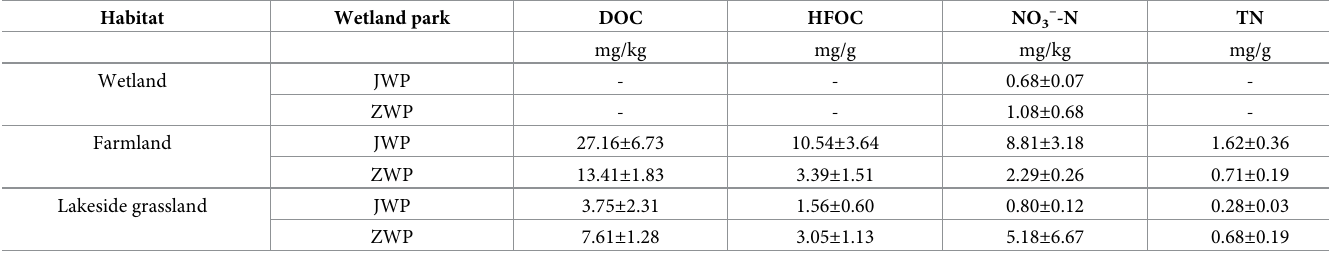
Values are expressed as mean ± standard deviations. JWP is Shili Lake Ecological Wetland Park. ZWP is Shandong Zoucheng Taiping National Wetland Park. DOC: dissolved organic carbon; HFOC: heavy fraction organic carbon; NO 3– -N: nitrate nitrogen; TN: total nitrogen; Factors with no data show no significant differences between the two parks in the three habitats ( p <